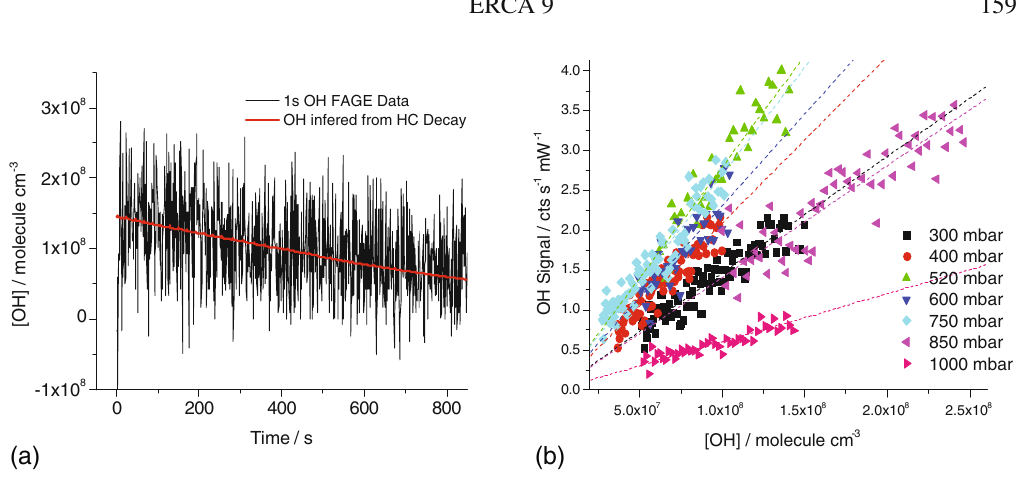
Fig. 11. (a) Comparison of OH concentrations calculated from hydrocarbon decays and photolytically calibrated FAGE measurements. (b) Variation of sensitivity as a function of external pressure. The studies were carried out at constant pumping speed so there is a corresponding variation in the internal